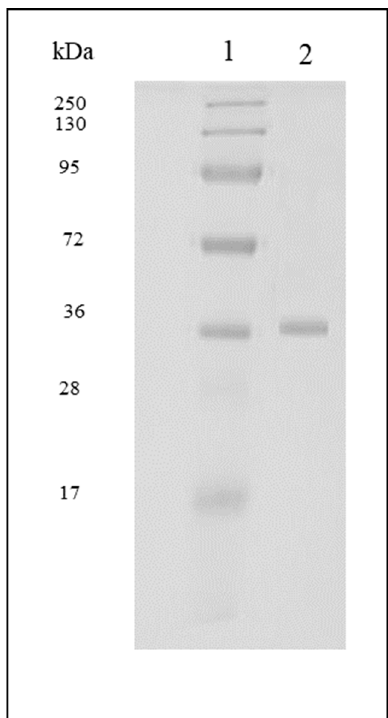
Figure 3. Sodium Dodecyl Sulphate-Polyacrylamide Gel Electrophoresis (SDS-PAGE) (1) molecular size markers; (2) purified xylanase.